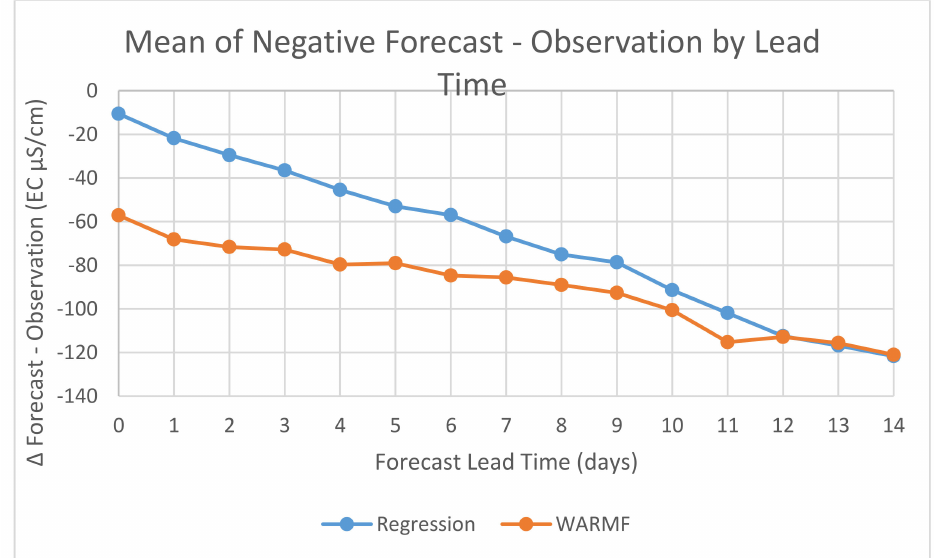
Figure 9. Comparison of means of forecasted and observed EC for the Regression and WARMF models for the period between 22 February 2018 and 22 May 2020. Data censored to include only under